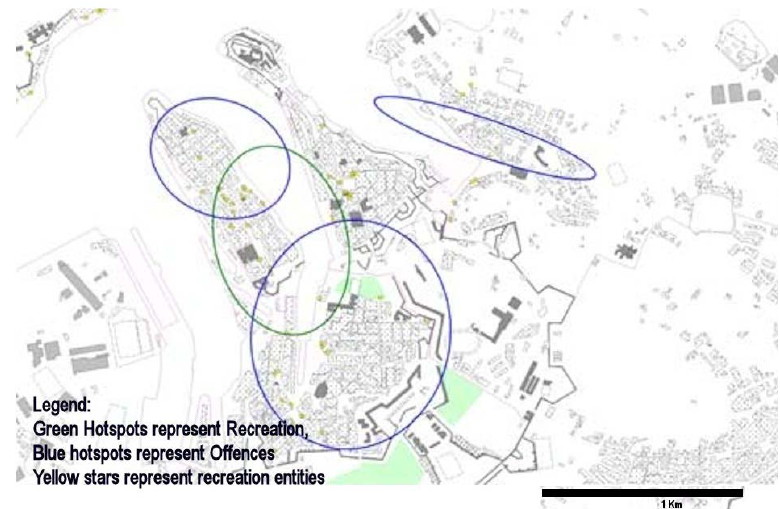
Figure 2. Crime Maps—Overlaying offence and Retail/recreation